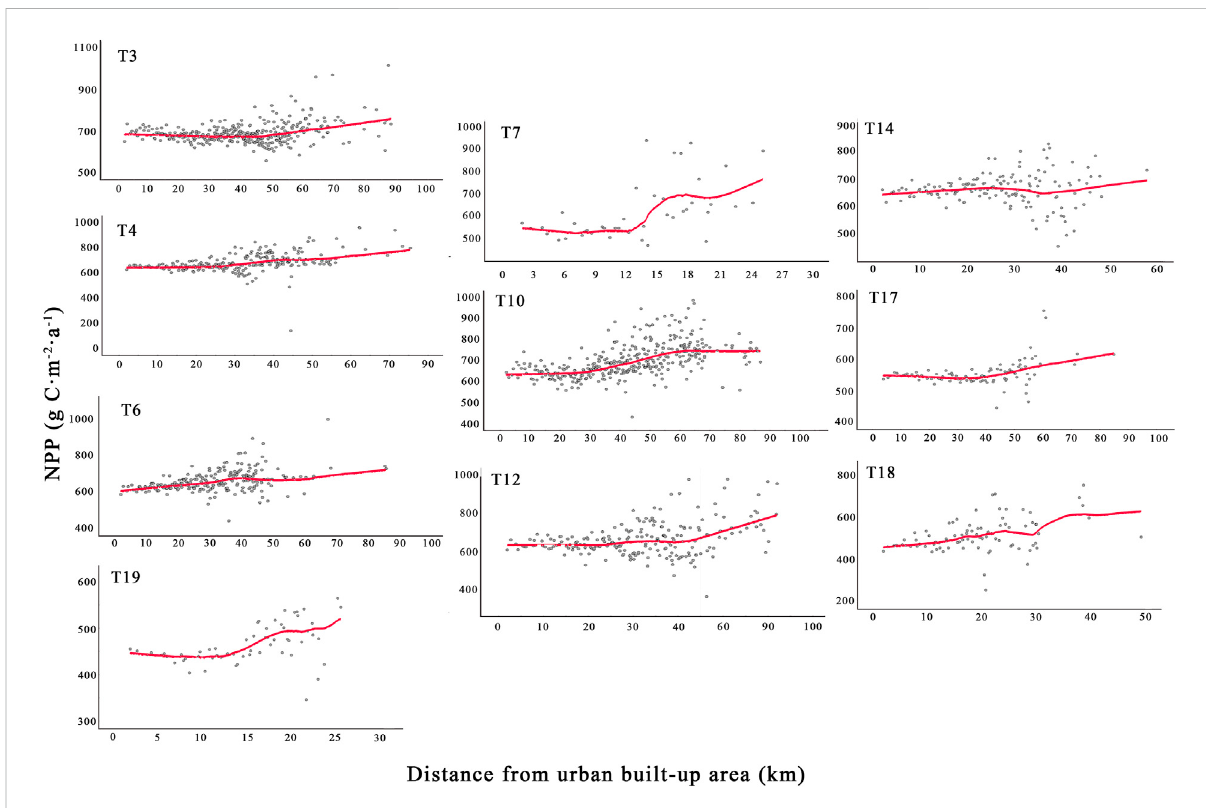
FIGURE 6 Rising relationships between NPP supply capacity and distance from built-up